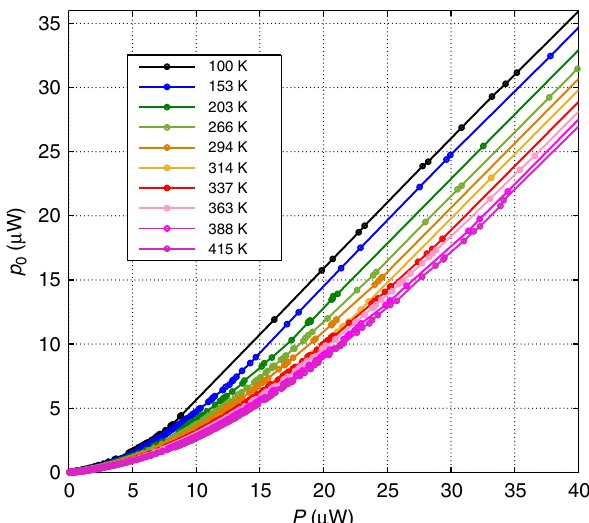
Fig. 3 Experimental condensation P dependence for various temperatures. The condensation is given by the light concentration near the cutoff wavelength. Beside the initial slow grow part near zero P , the graphs are almost straight lines showing a linear P dependence with a similar slope of